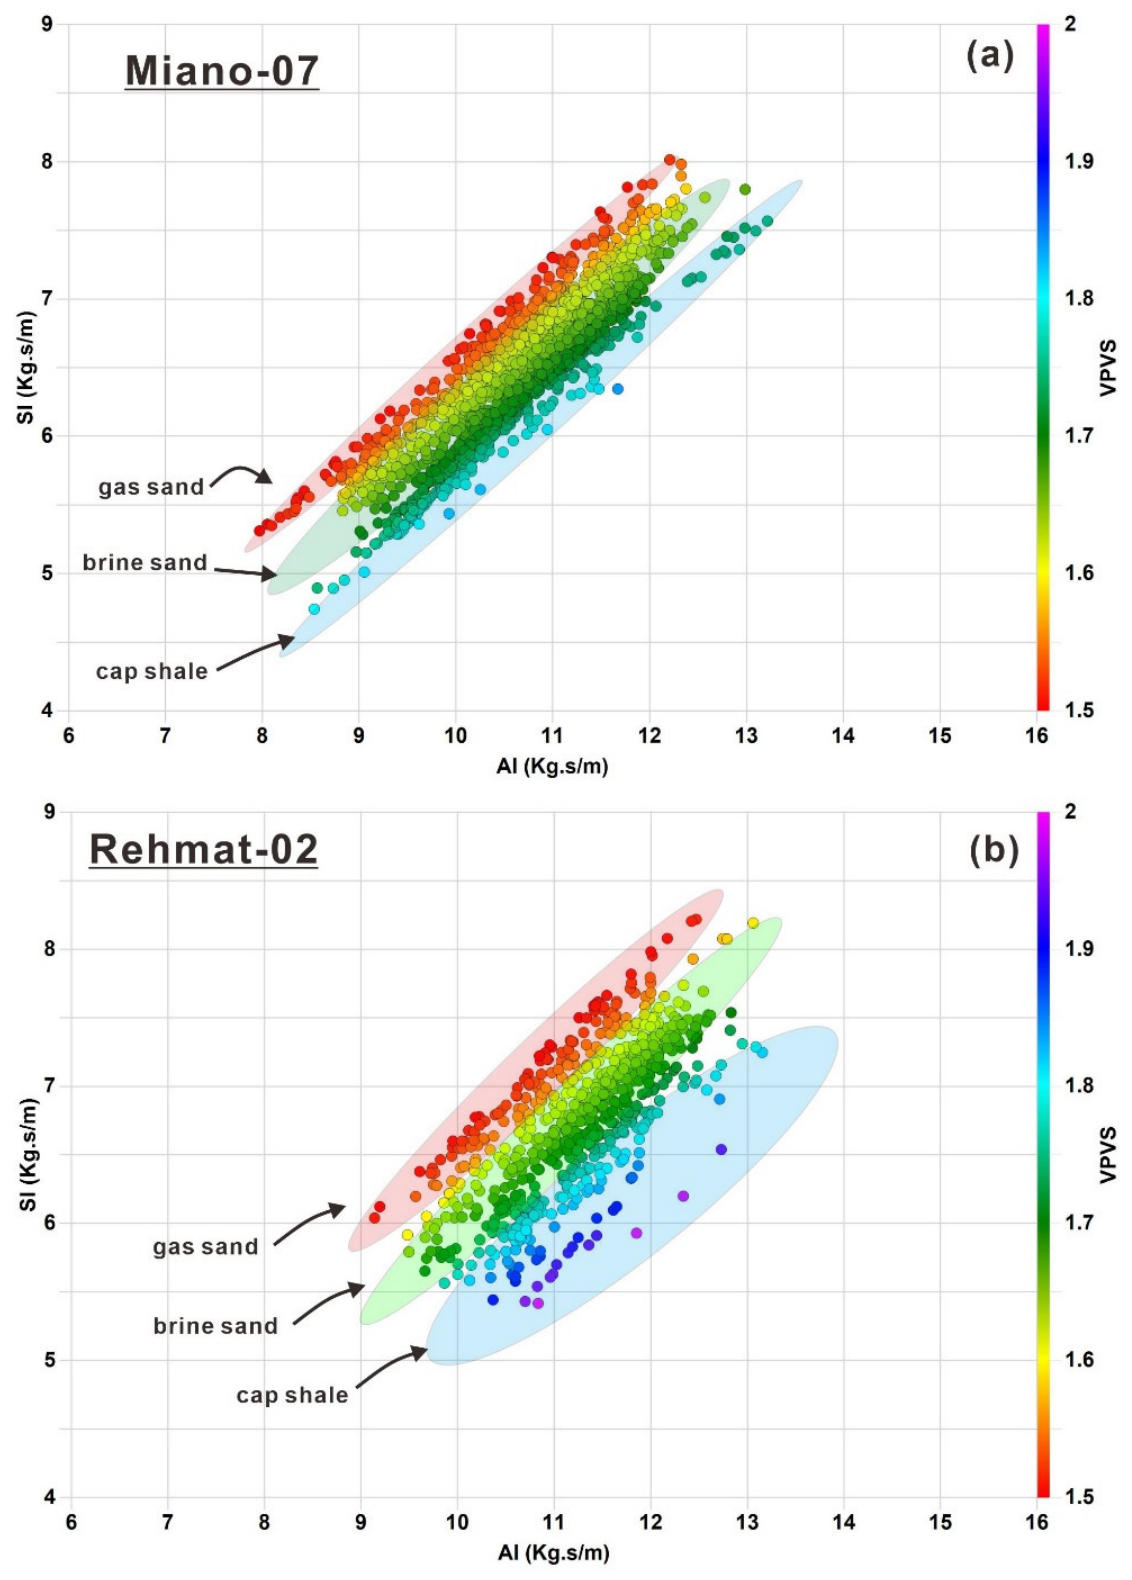
Figure 12. The RPT across SI versus AI of ( a ) Miano-01 and ( b ) Rehmat-02 wells at the targeted intervals to showcase gas-saturated (red box), brine sand (green box), and cap shale (blue box) zones.